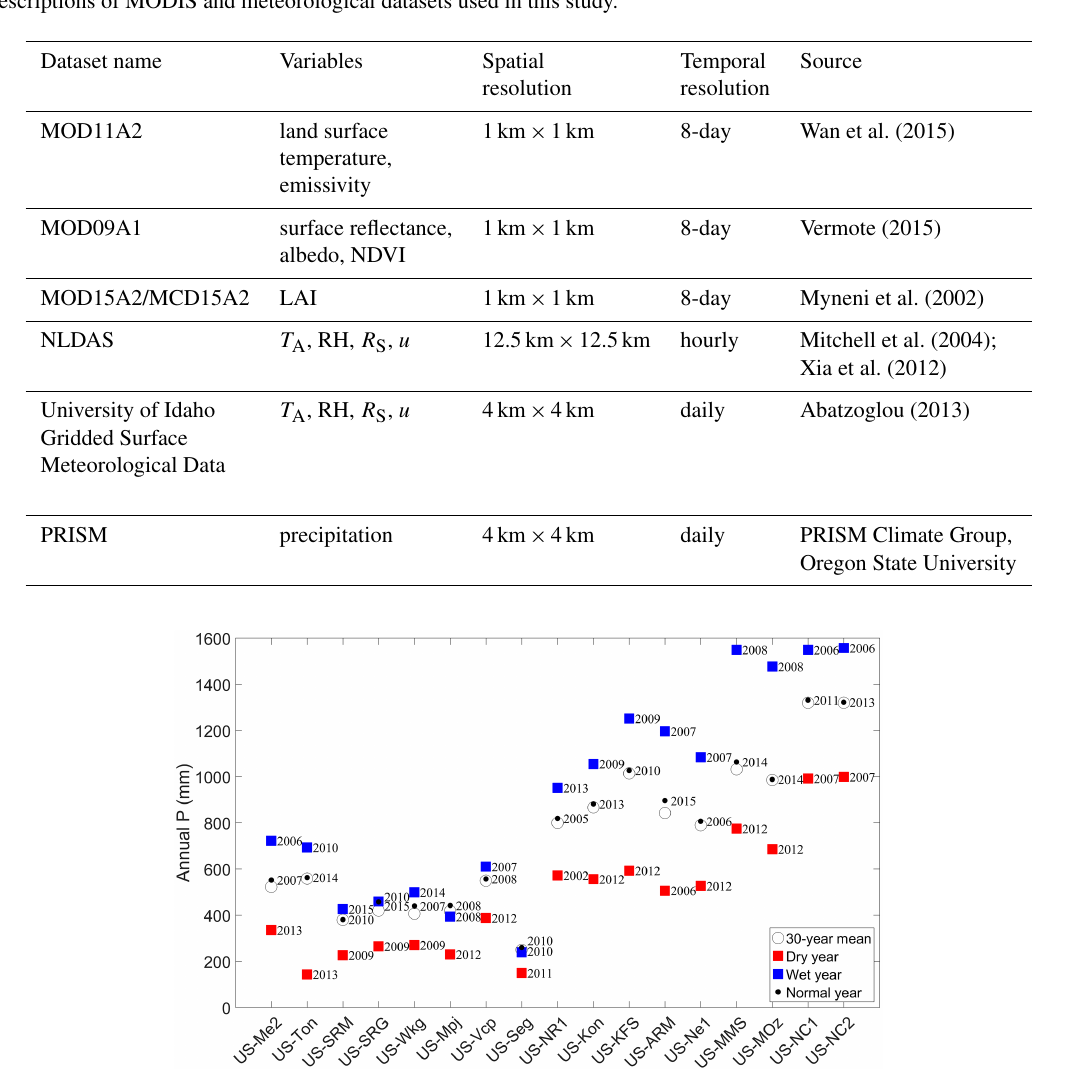
Figure 3. Distribution of annual precipitation ( P ) during dry, wet, and normal years considered for ET evaluation at each site corresponding to its 30-year mean annual precipitation from the PRISM